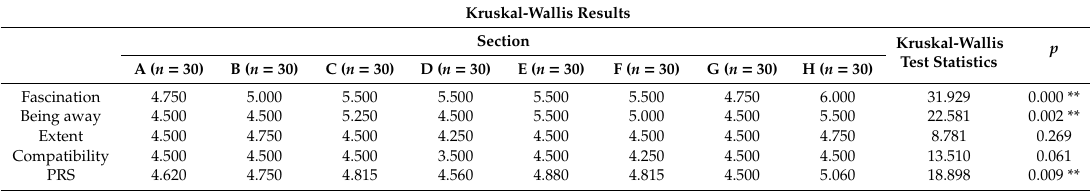
Table A4. PRS Kruskal–Wallis results.